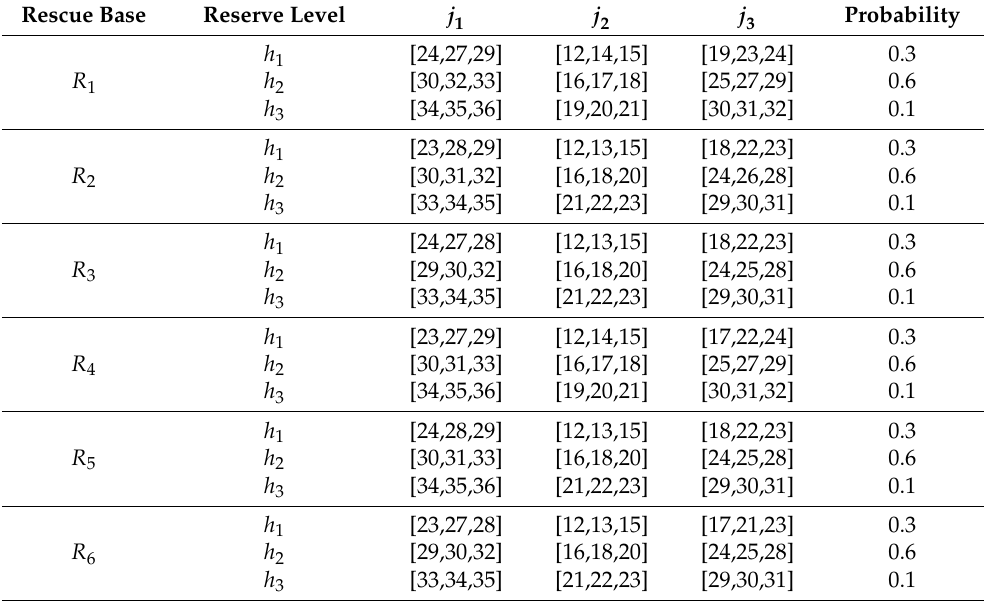
Table 5. Quantity and probability distribution of R i materials in each emergency rescue base (items). Rescue